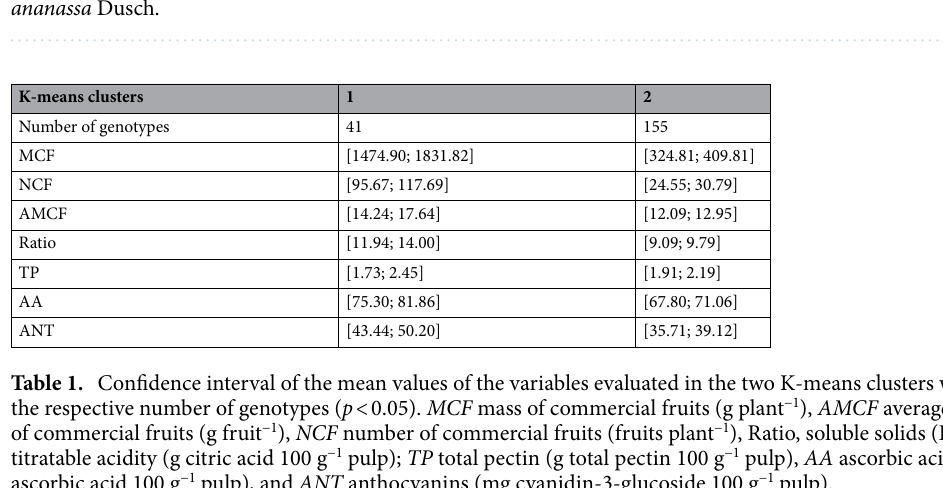
Figure 2. K-means cluster analysis for yield and biochemical traits evaluated in 10 populations of Fragaria × ananassa Dusch.